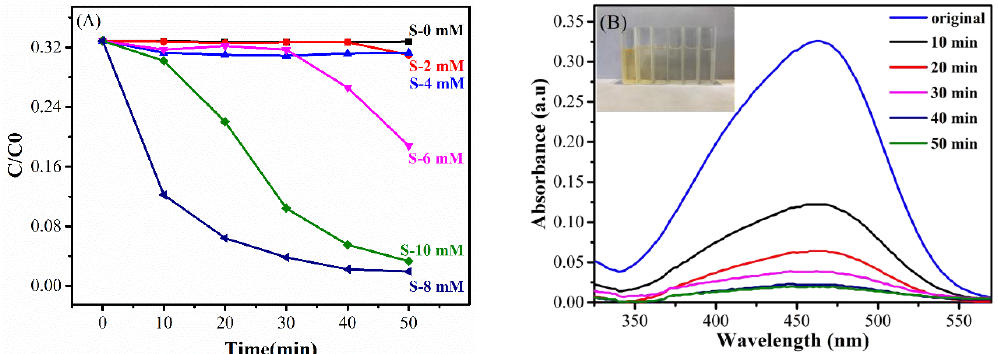
Figure 8. Schematic illustration of the Ag@Cu 2 O-rGO charge transfer in the photocatalytic degradation process of MO. 4. Conclusions In summary, we designed a heterostructure of Ag@Cu 2 O-reduced graphene oxide (rGO) with the core-shell complex-structure. The rGO nanosheets act as a sheet platform and the Ag@Cu 2 O core- shell nanoparticles are decorating the surface of the rGO, which forms a 2D+0D heterogeneous structure. Cu 2 O nanoparticles occupy the defect positions on the surface of the rGO platform and restore the conjugation of the rGO structure, which contributes to the significant decrease of the I D / I G intensity ratio. The rGO platform can not only bridge the isolated nanoparticles together but also can quickly transfer the free electrons arising from the Ag core to the Cu 2 O shell to improve the utilization efficiency of photogenerated electrons. The broadened absorption of visible light and high efficient photocatalytic activity to MO in Ag@Cu 2 O-rGO indicates the strong light–matter interactions.